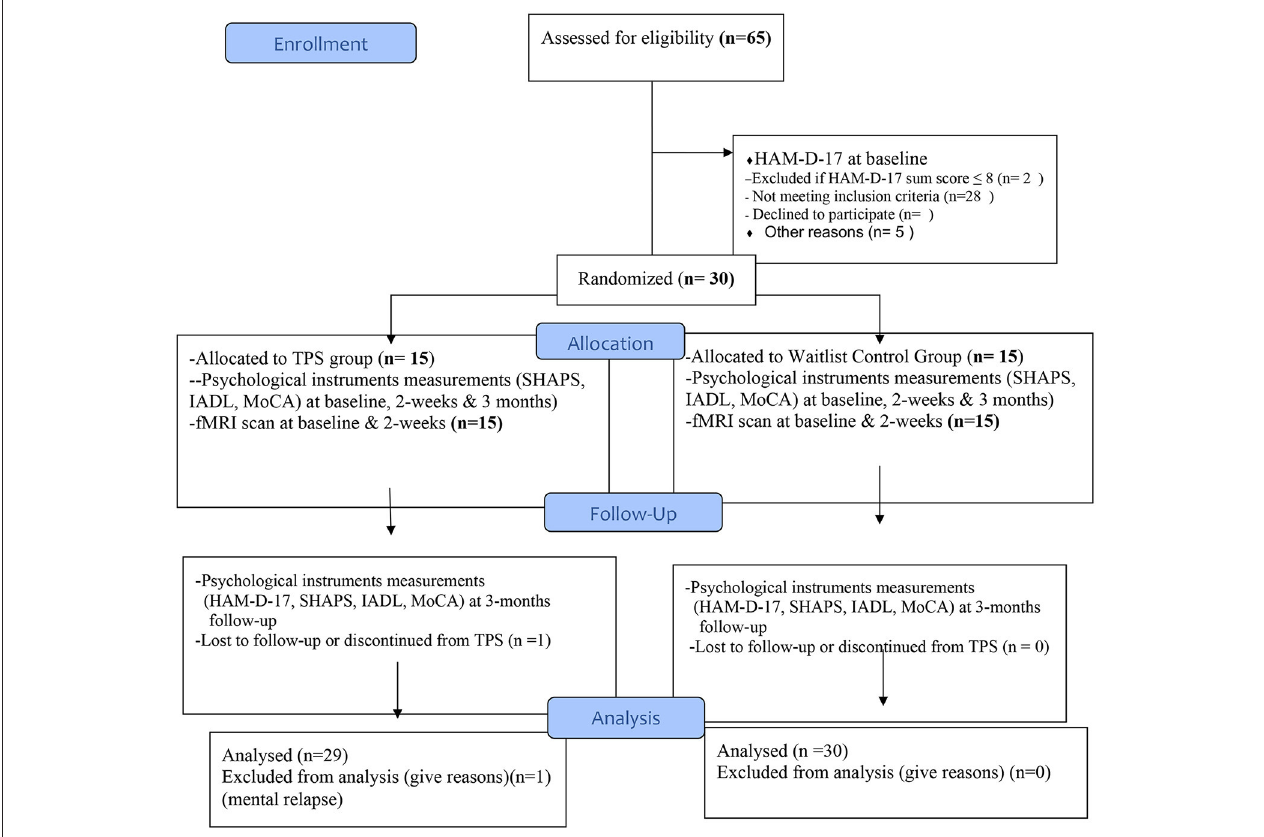
FIGURE 5 | Flow diagram for participants’ enrollment, randomisation, allocation, and follow-up (CONSORT,